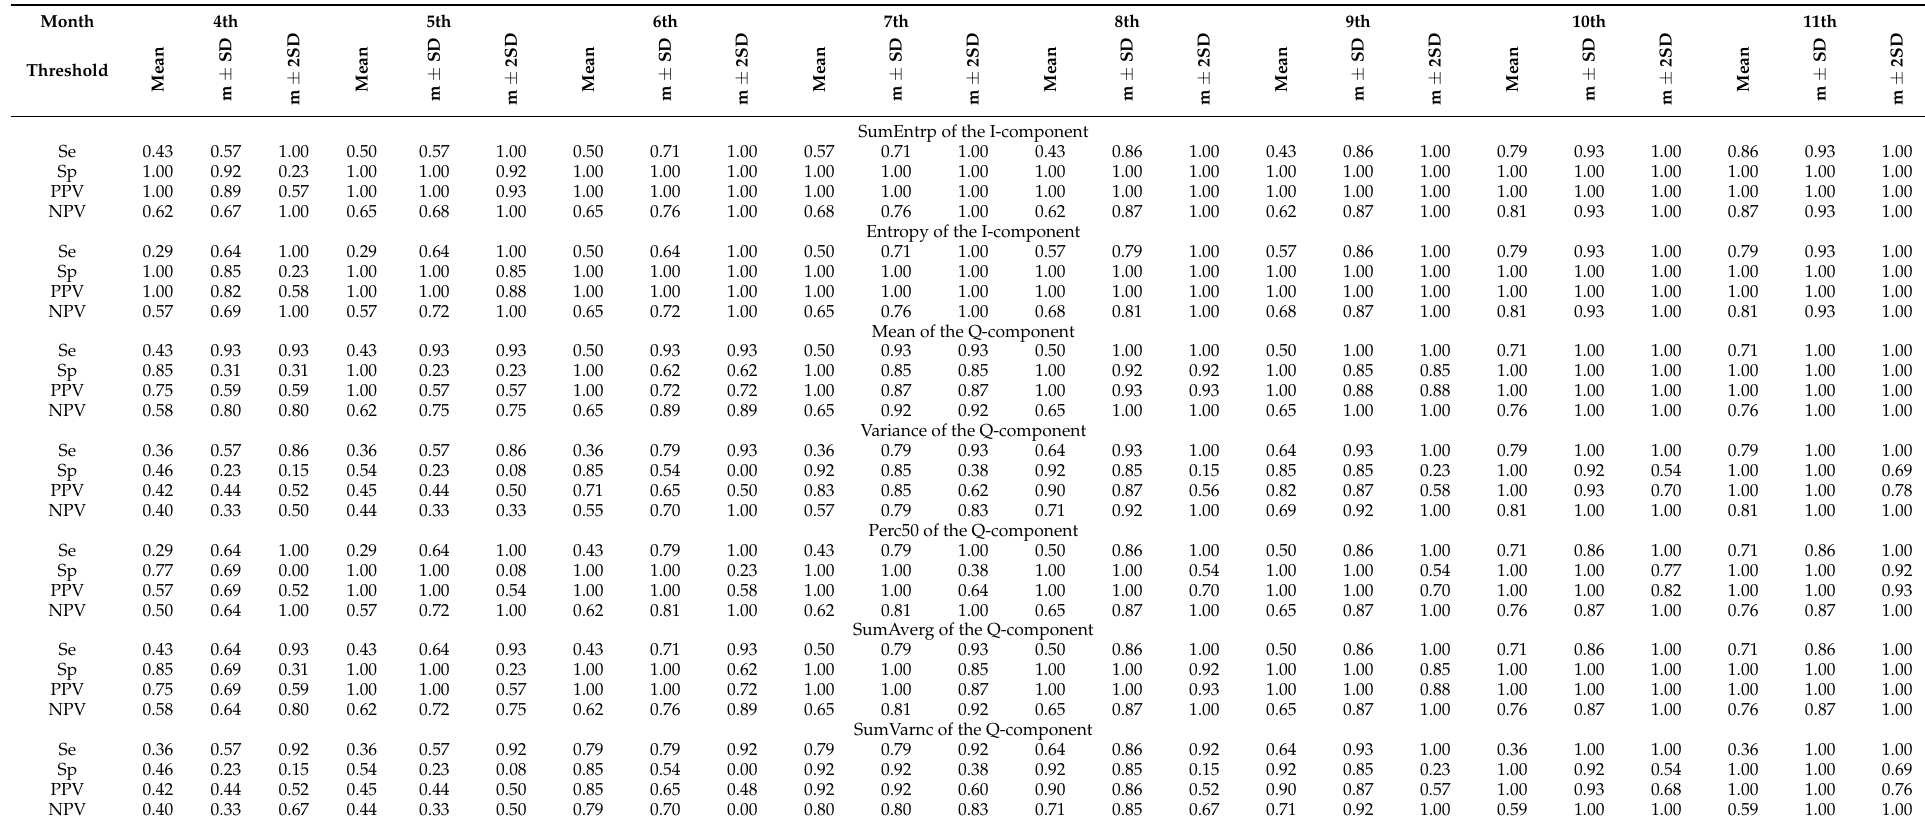
Table 2. Three thresholds (mean; mean ± SD (m ± SD); mean ± 2SD (m ± 2SD)) used to estimate the sensitivity (Se), specificity (Sp), positive predictive value (PPV), and negative predictive value (NPV) of pregnancy detection using the selected features of Histogram Statistics and Gray Level Co-occurrence Matrix in the YIQ color